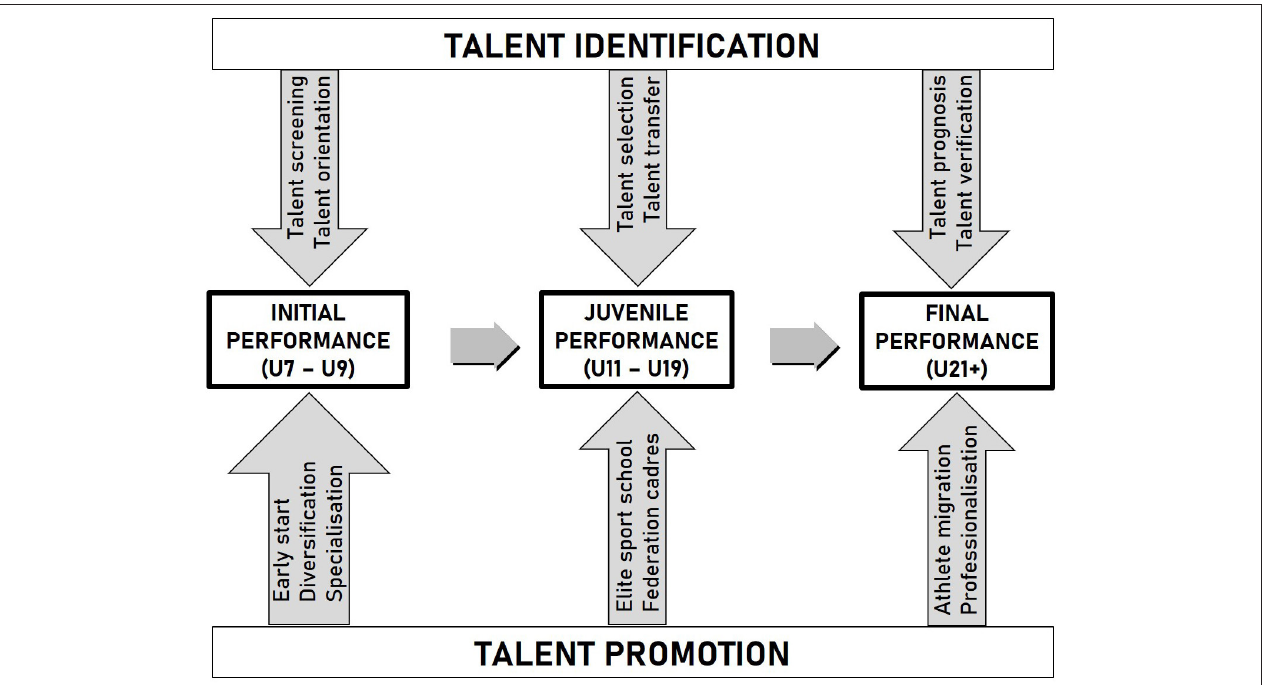
FIGURE 1 | Talent identification and talent promotion as the two intertwined strategies in the long-term talent development model (mod. from Hohmann and Seidel, 2003